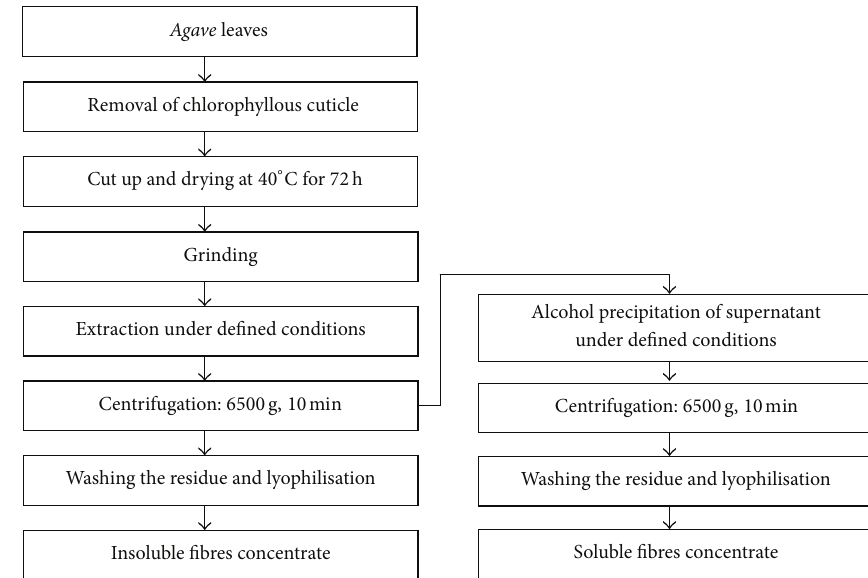
Figure 1: Elaboration process of insoluble and soluble fibres concentrates from Agave americana